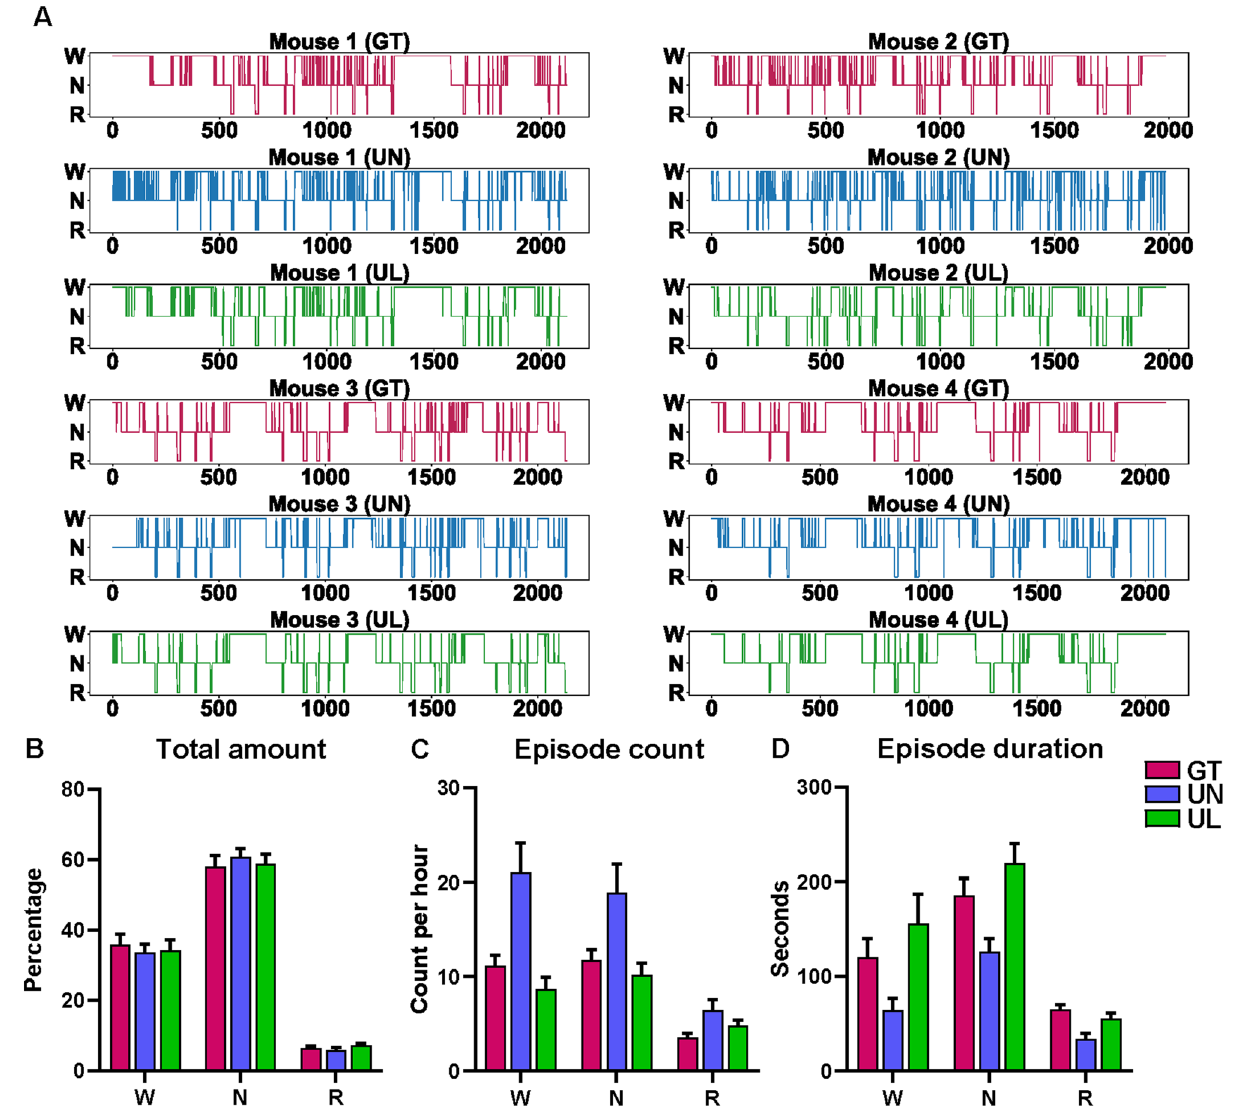
Figure 3. Sleep architecture analysis from testing. ( A ) Hypnogram, ( B – D ) sleep architecture. W, wakefulness; N, NREM; R, REM; GT, ground truth; UN, UTSN; UL, UTSN-L; WN, wakefulness to NREM; WR, wakefulness to REM; SN, NREM to wakefulness; NR, NREM to REM; RW, REM to wakefulness; RN, REM to NREM. Data are shown as mean 95% confidence interval (n = 22 recordings).